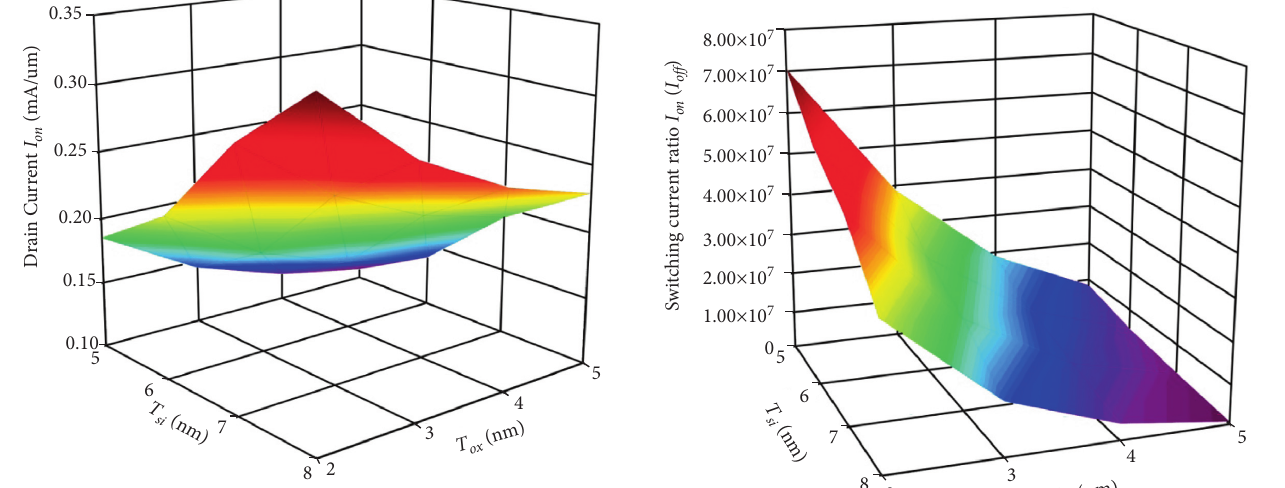
Figure 10: The turn-on current I on with different T si and T ox at Turn-on State 3. Figure 11: The switching current ratio I on / I off with different T si and T ox at Turn-on State